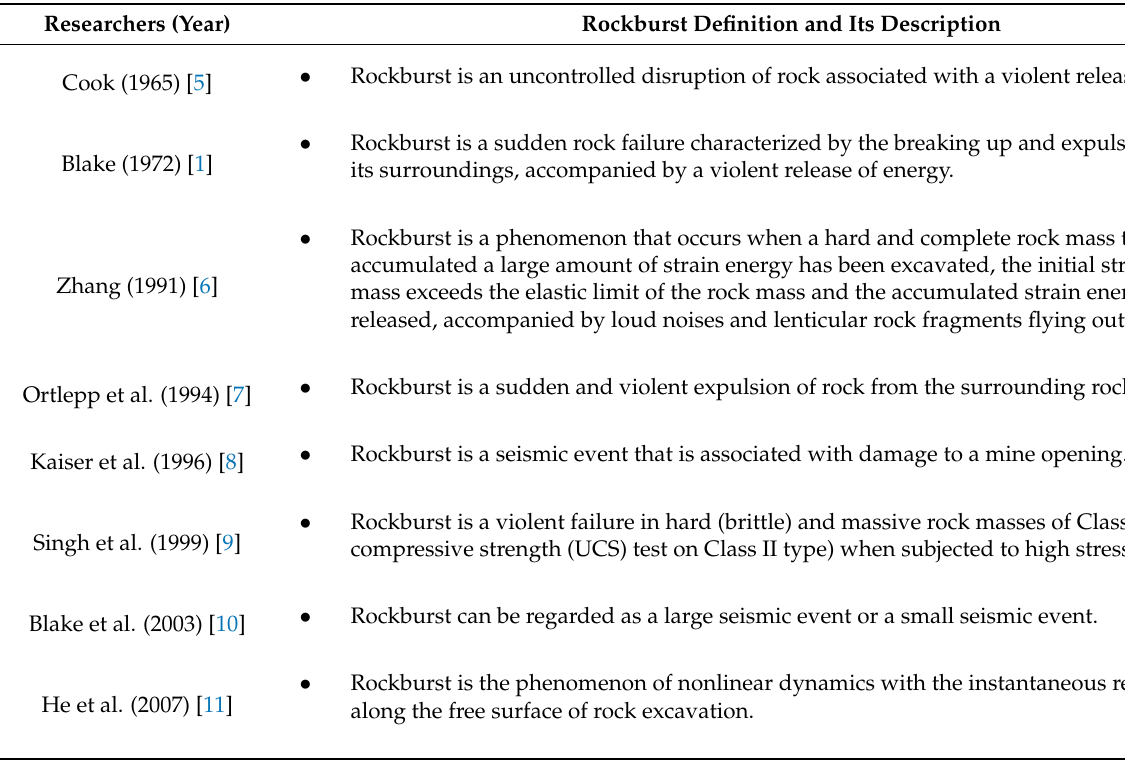
Table 1. Rockburst